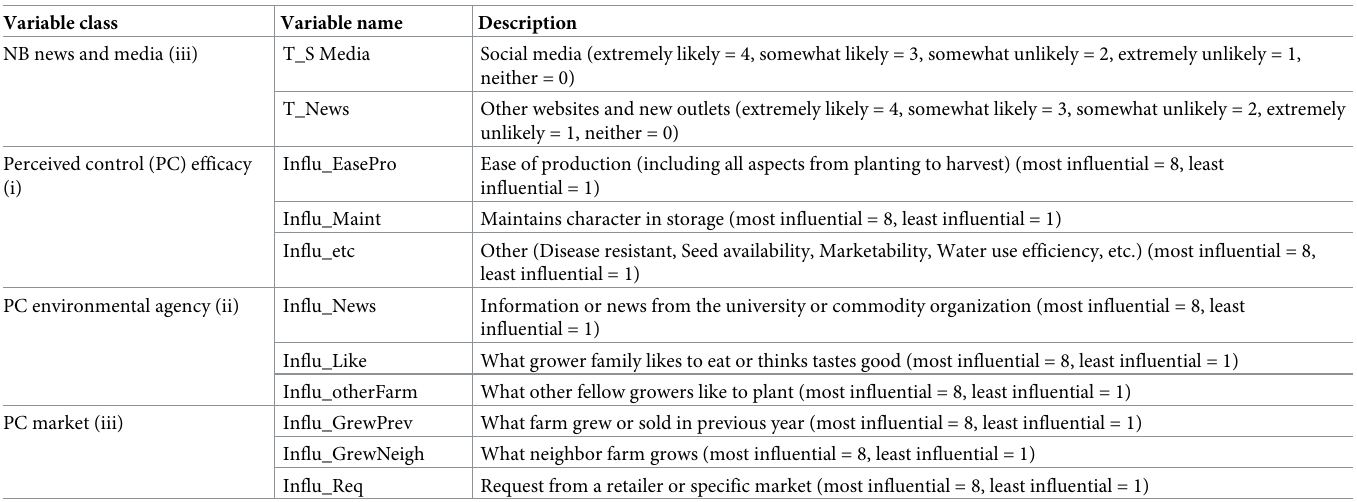
80 potato growers responding (59%, out of the 135 total SLV potato growers indicated by CPAC); 76 of the responses were complete and used in the analysis. We administered the sur- vey in person on tablet computers using Qualtrics [78] at an agricultural conference in the SLV. The survey included four sections to investigate our hypothesis: (A) background factors, (B) behavioral belief factors, (C) normative belief factors, and (D) perceived control factors. In the survey, we defined SCs as any potato other than white Russet potatoes (e.g., yellow, red, purple, fingerling, etc.). For translation of the survey to modeling, an adopter is defined as any grower who produced SCs in the previous growing season.